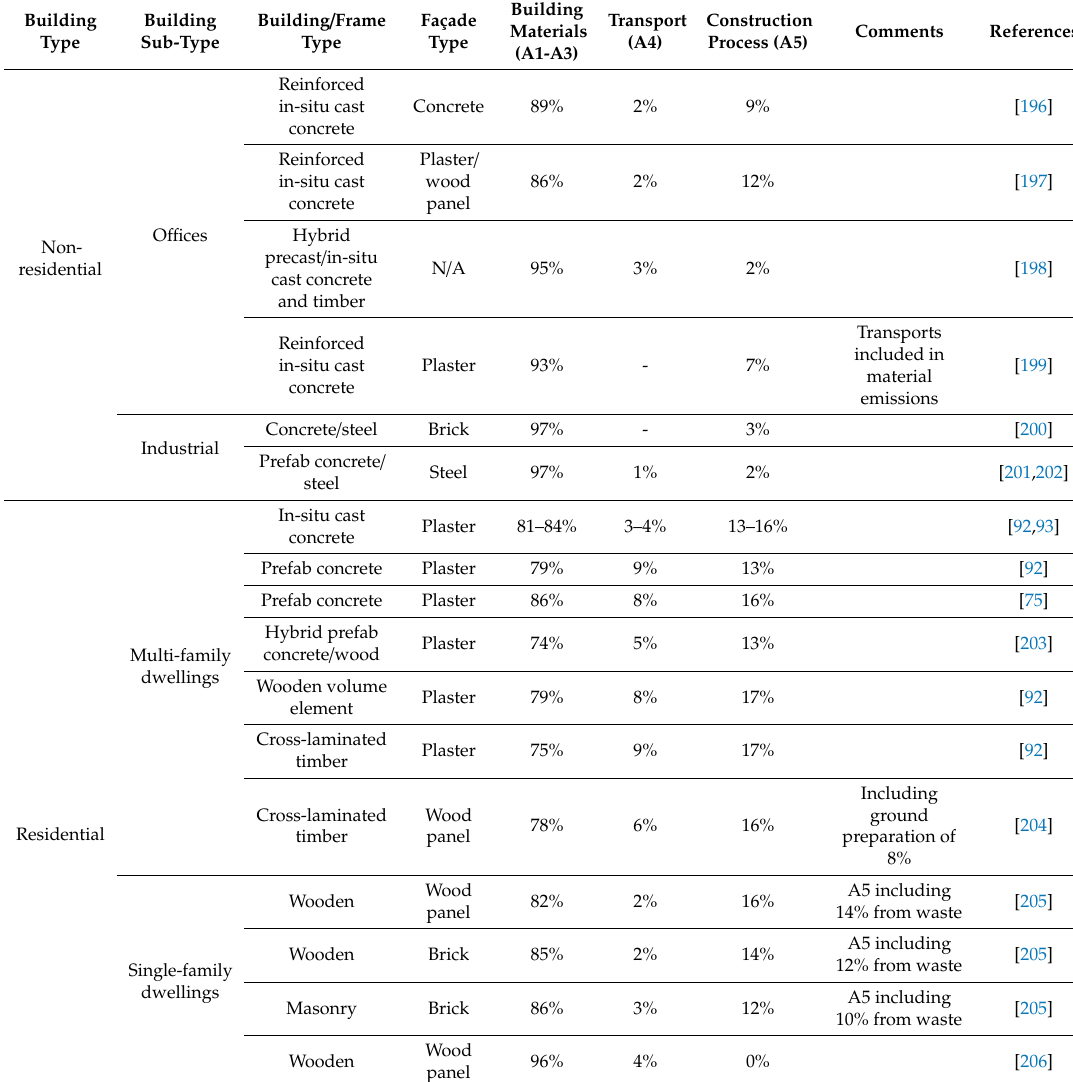
Table A4. Overview of the share of emission components from life cycle analysis (LCA) literature for new builds of various building and frame